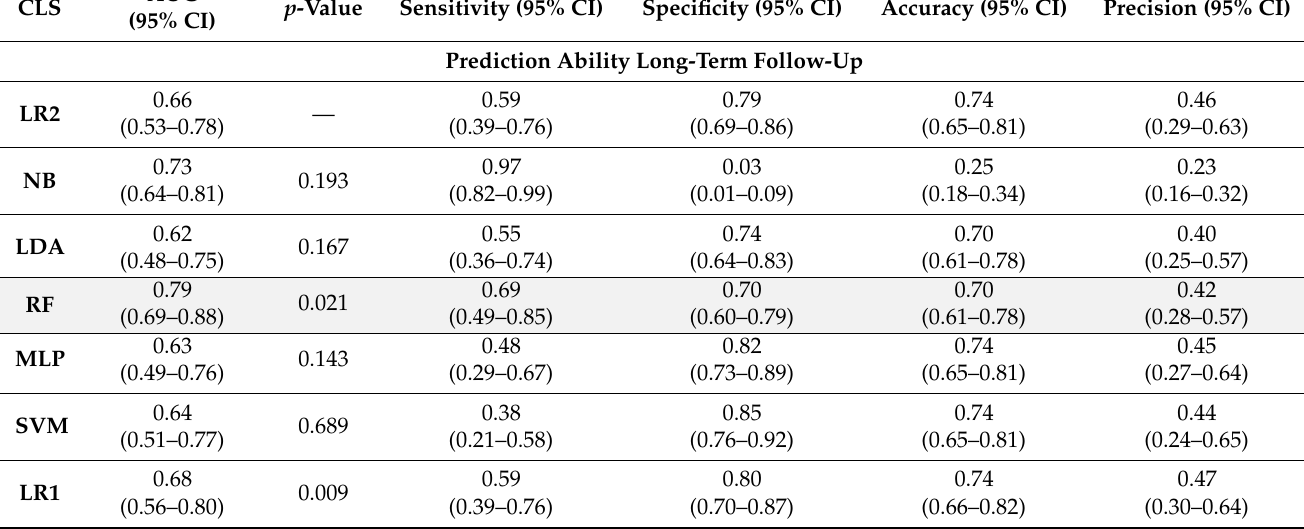
CLS, classifiers; AUC, Area Under the Curve; CI, confidence interval; LR, Logistic Regression; NB, Naive Bayes; LDA, Linear Discriminant Analysis; RF, Random Forest; MLP, Multi-layer Perceptron; SVM, Support Vector Machine.